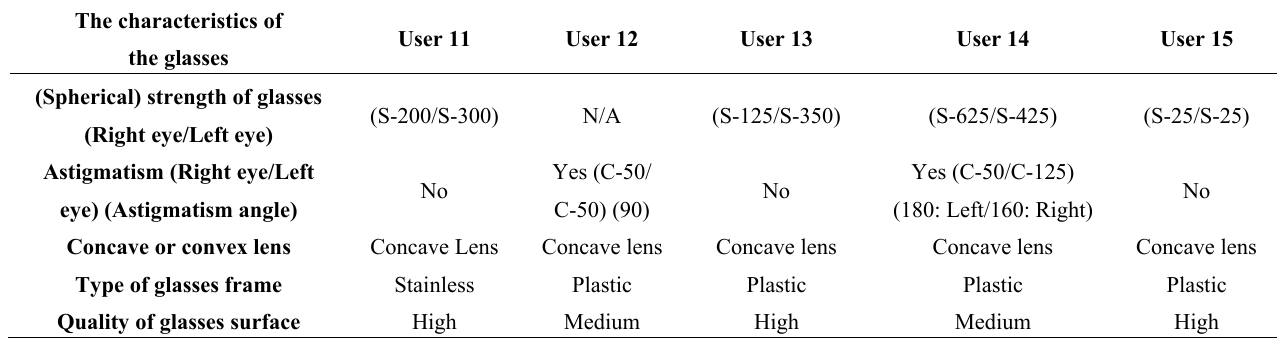
Table 12. The characteristics of the glasses of users